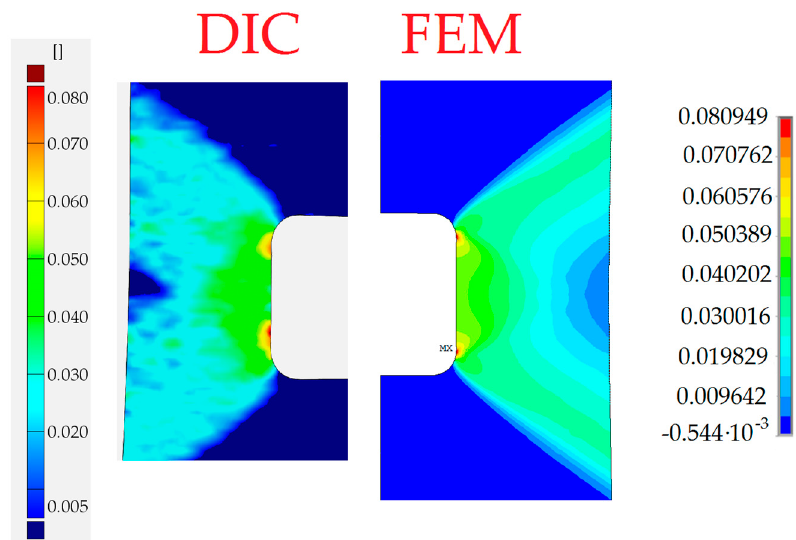
Figure 24. GOM–ANSYS comparison of total vertical strains distributions.